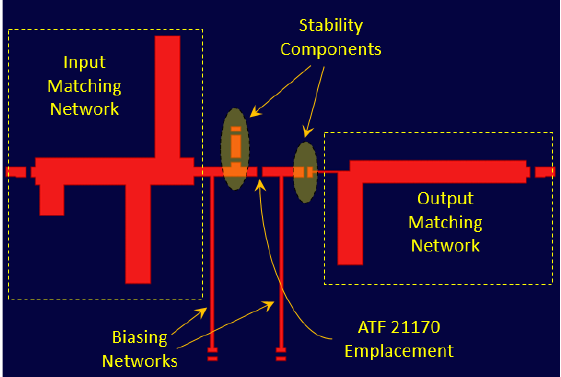
Fig. 12. The proposed LNA layout